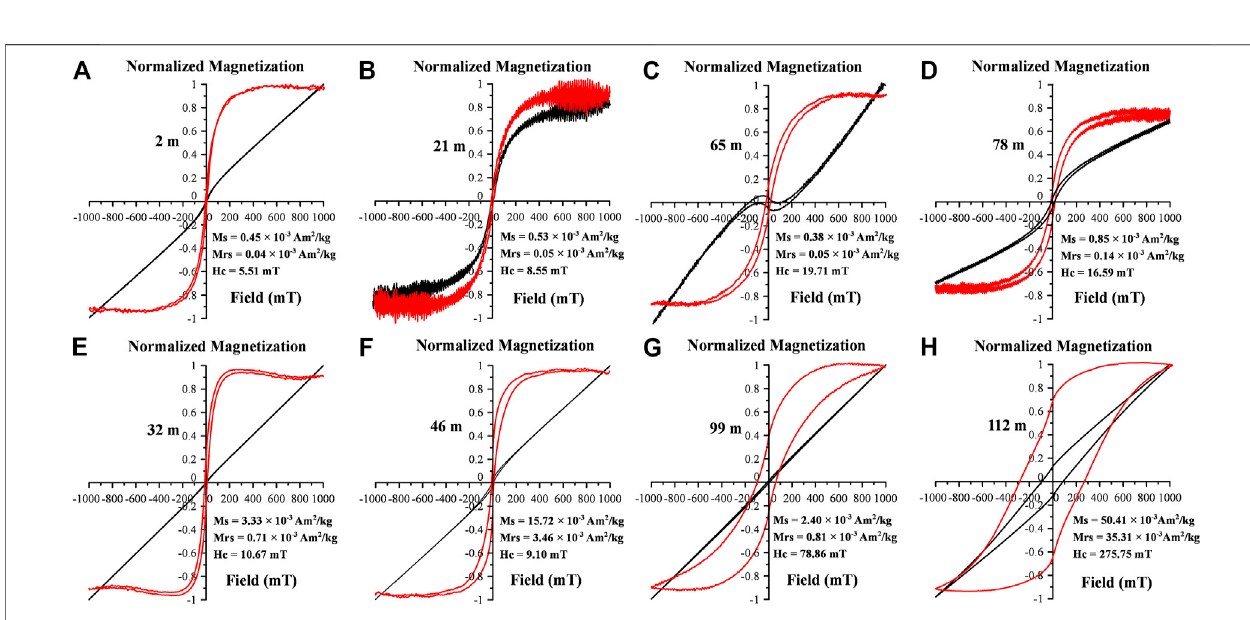
Frontiers in Earth Science |